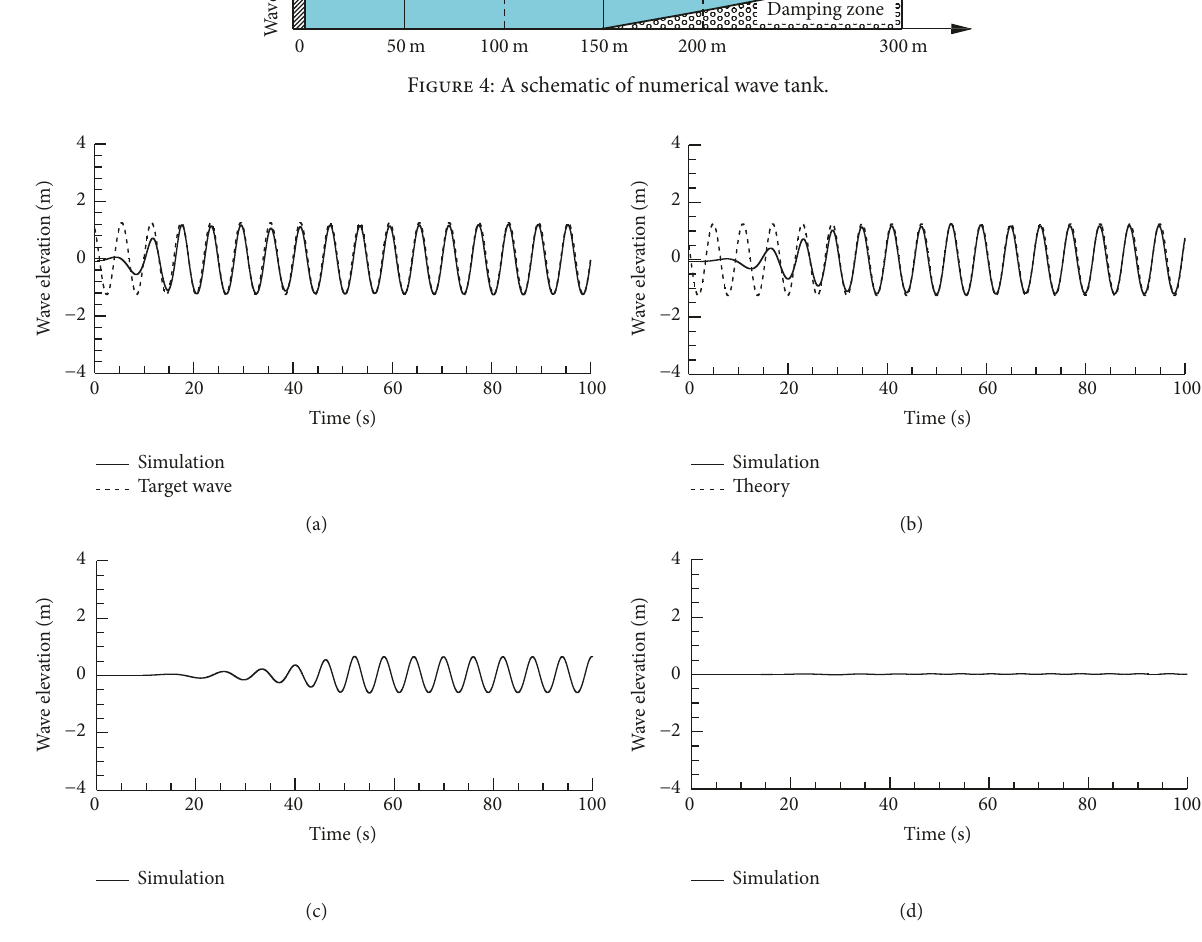
Figure 5: Wave elevation at four different locations: (a) 𝑥 = 50 m; (b) 𝑥 = 100m; (c) 𝑥 = 200 m; (d) 𝑥 = 300 m.